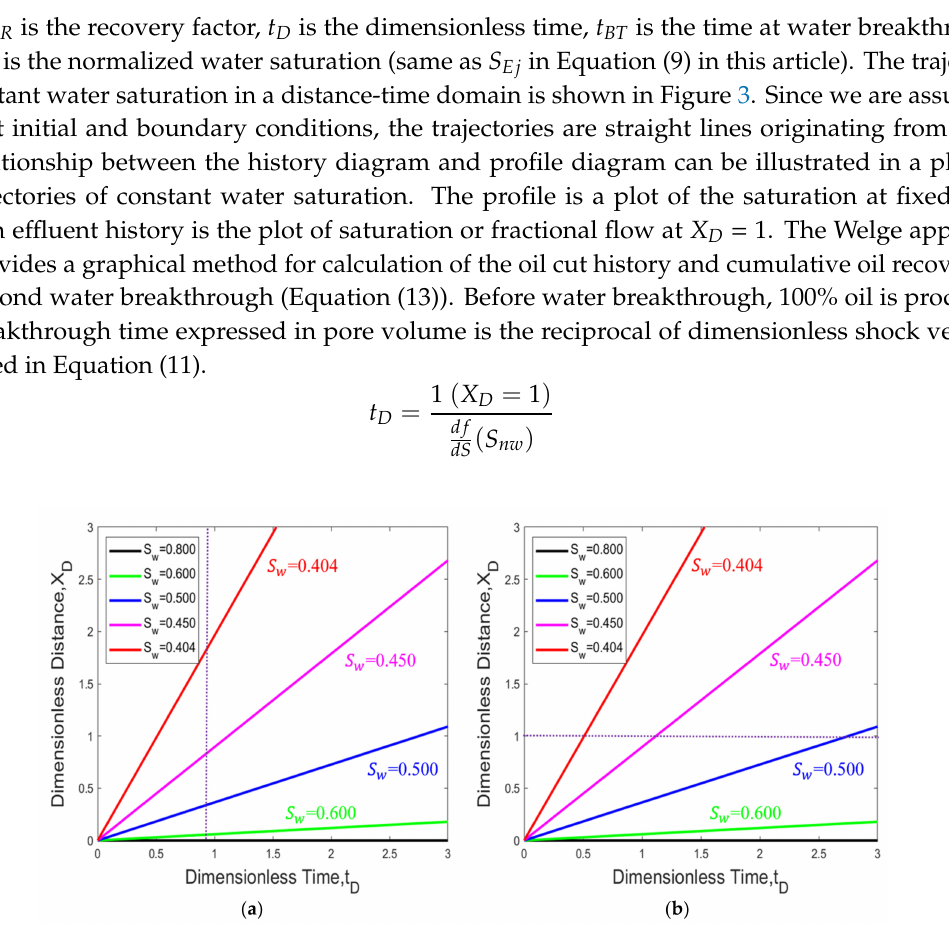
Figure 3. Trajectory of constant water saturation in distance time diagram; ( a ) Construction of saturation profile plot, and ( b ) Construction of e ffl uent history